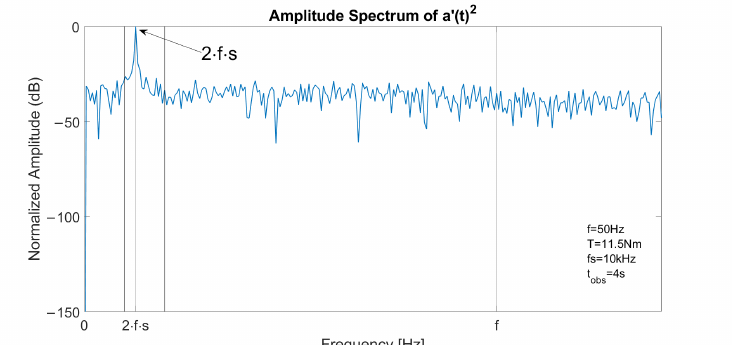
Figure 4. Spectrum of the square of the analytical signal a (cid:48) ( t ) 2 of a stator current in case of one broken bar, constant speed at 1500 rpm and slip 6%. The main component is located at 2 sf